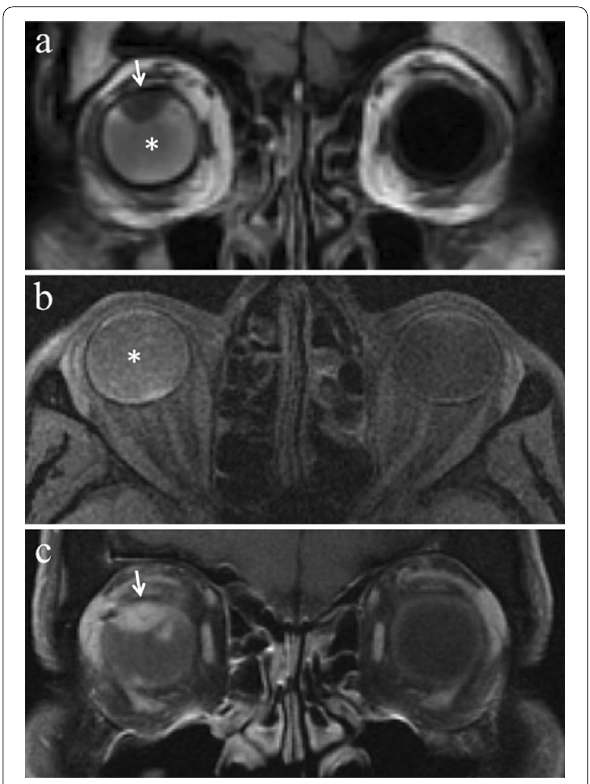
Fig. 9 A 37-year-old man with radiation-induced endophthalmitis after proton-beam radiotherapy for choroidal melanoma of the right eye. The patient underwent secondary enucleation three years after radiotherapy because of drug-resistant neovascular glaucoma and painful eye, associated with local recurrence. a Coronal T2-weighted FLAIR (from brain MRI scan) and b axial fat-suppressed T1-weighted images show increased signal intensity of the vitreous body of the right eye (white asterisks) due to vitreous inflammation with protein leakage; note the difference with the physiological water-like signal intensity of the contralateral eye. Along the superior aspect of the right globe, a dome-shaped intraocular mass is detectable, consistent with local recurrence of the choroidal melanoma (white arrow in a ). On ( c ) coronal contrast-enhanced fat-suppressed T1-weighted image, the mass demonstrates enhancement (white arrow)